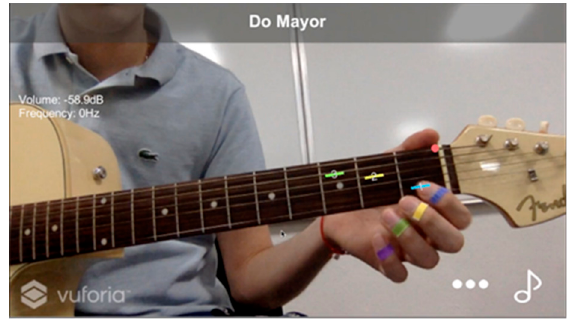
Figure 2. Example superimposed image of Augmented Reality (AR) color-coded instructions.